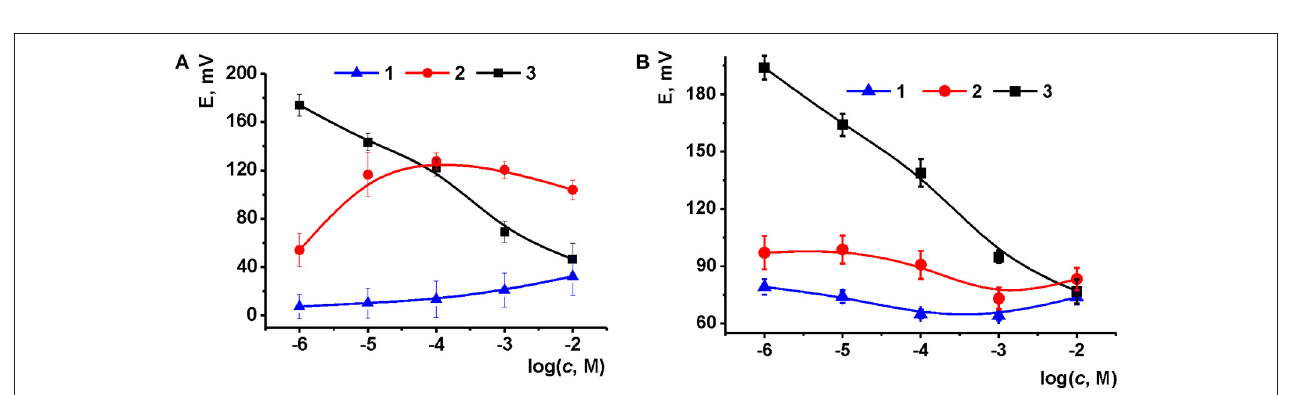
FIGURE 5 | Calibration curves of Na 2 HPO 4 obtained with the potential sensors based on CB (A) and MWCNTs (B) support (2 µ L of 1.0 mg/mL suspension) and IL 1 [aliquot of 1 µ L of 0.1mM solution (1), 1 µ L of 1.0mM solution (2) and 2 µ L of 1.0mM solution (3)]. Layer-by-layer deposition, pH 8.0. Average from three replications (mean ± S.D. for three